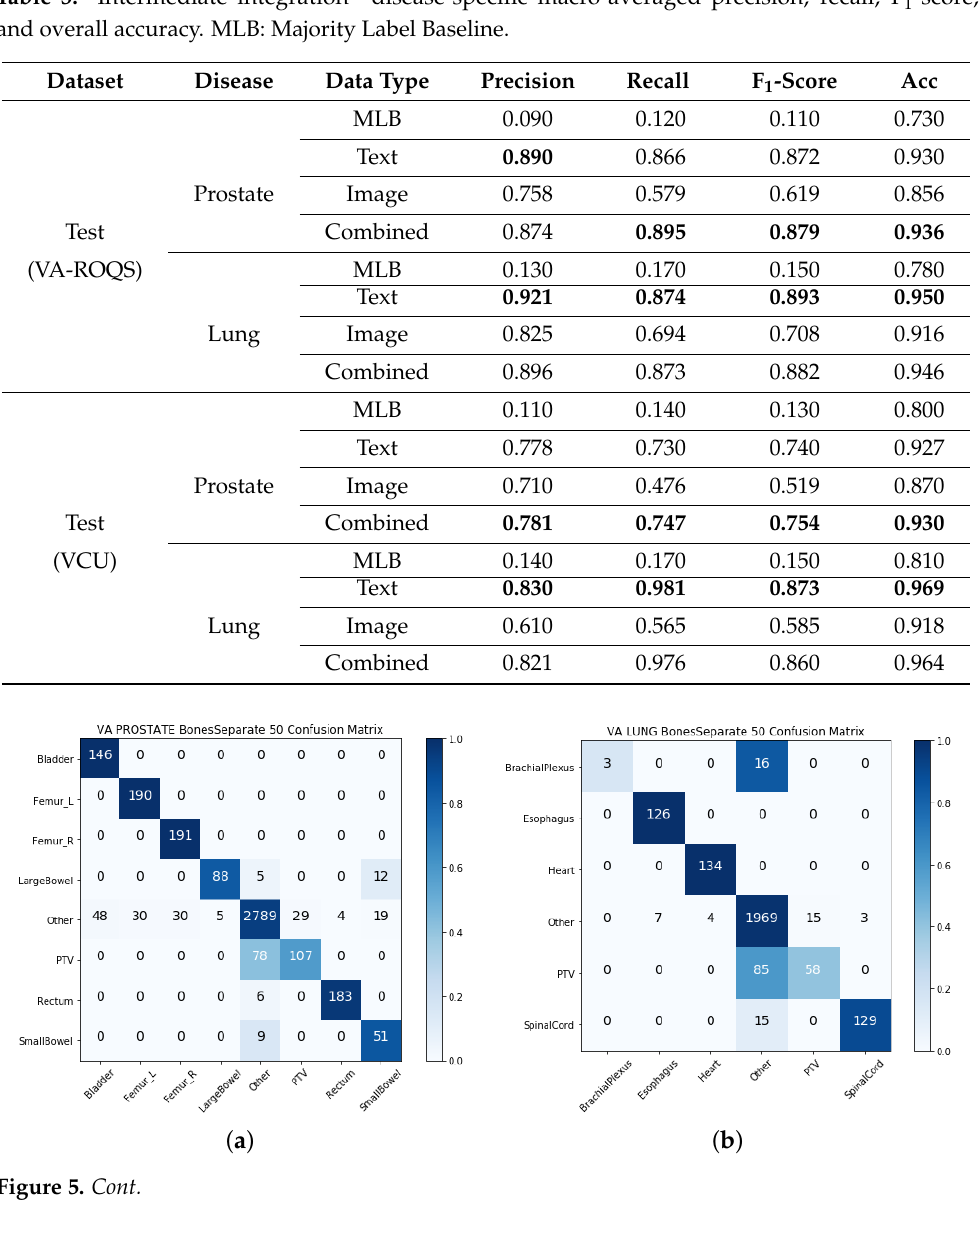
Table 3. Intermediate integration—disease-specific macro-averaged precision, recall, F 1 -score, and overall accuracy. MLB: Majority Label Baseline.